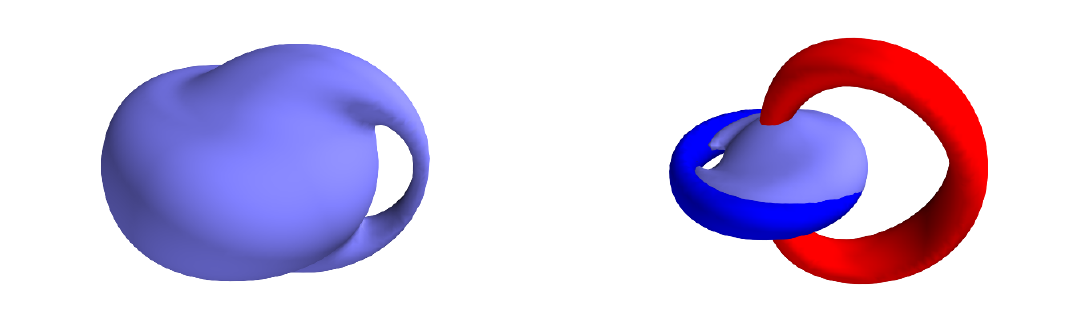
Figure 4 . Isosurfaces showing the energy density of the ( A 1 G A 1 ) A the Faddeev-Skyrme model (2.4) with the potential V = m 2 for E = 20 (left) and E = 100 together with the location curves (cid:30) 1 = (cid:6) 0 : 9 (right).